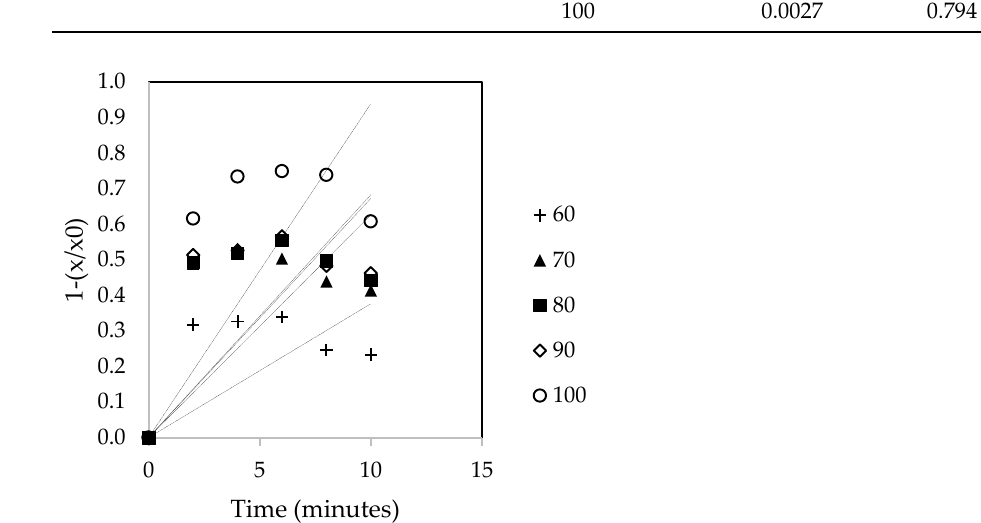
Figure 6. First-order kinetic model of the effect of blanching (60, 70, 80, 90 and 100 ° C) on the firm- ness of Dabai fruit.